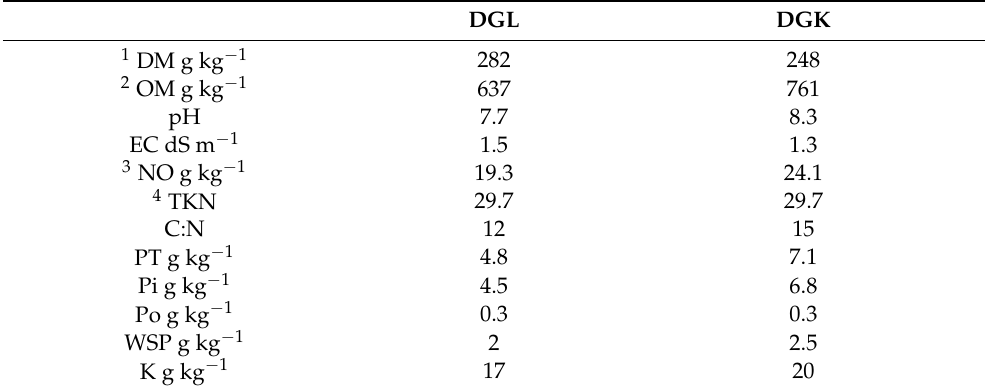
Table 2. Chemical composition of the solid fraction of the anaerobic digestates used in the field experiments. DGL was the digestate used in the lettuce experiment, and DGK was the digestate used in the kale experiment. DGL